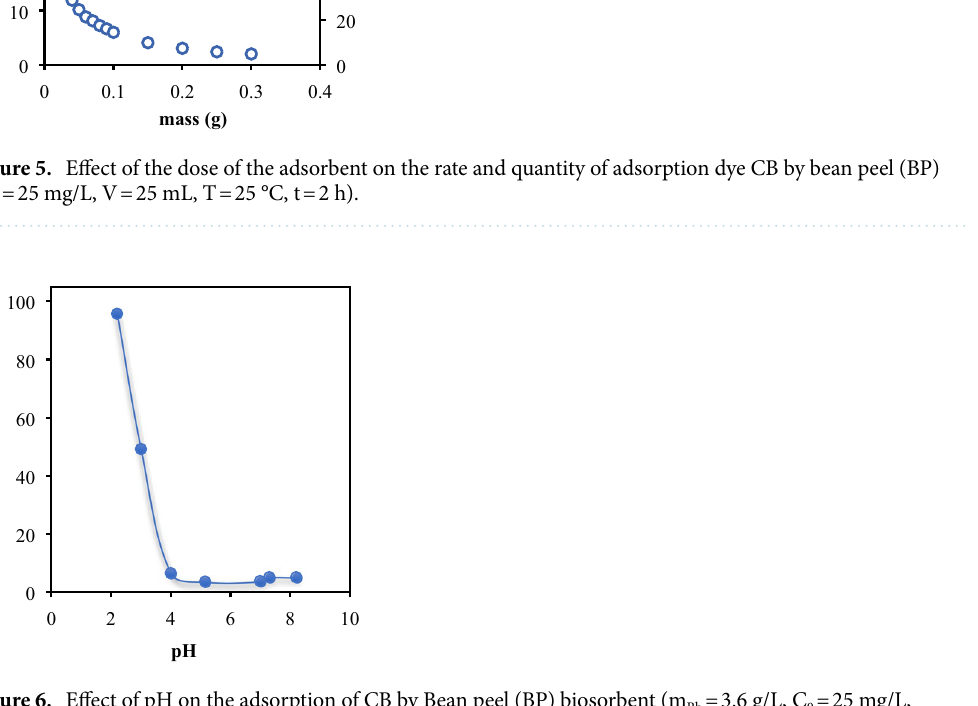
Figure 6. Effect of pH on the adsorption of CB by Bean peel (BP) biosorbent (m Bb = 3.6 g/L, C 0 = 25 mg/L, ω = 250 tr/min, T = 25 °C et t = 2